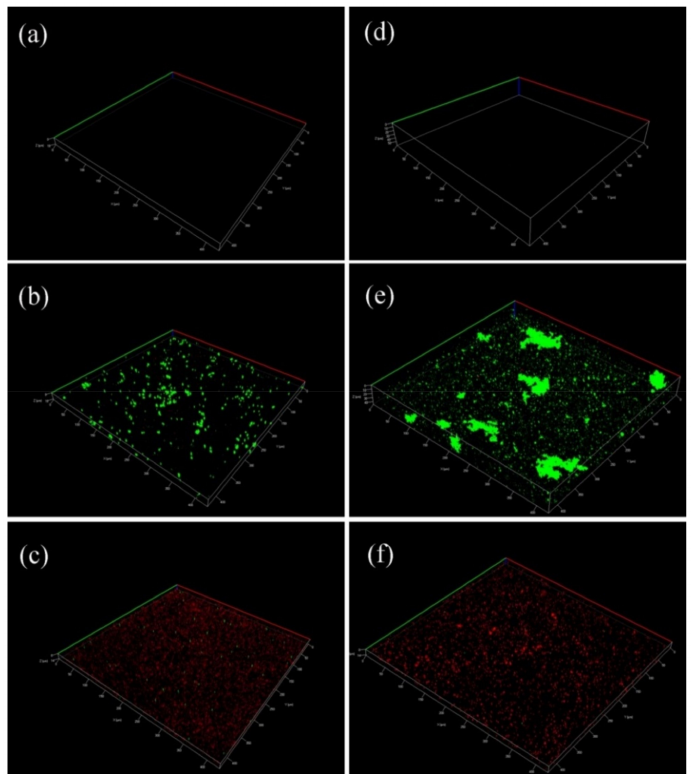
Figure 4. CLSM 3D images of the 304SS coupons after different immersion times in various solutions: ( a ) blank for 14 days; ( b ) SRB for 14 days; ( c ) BDMDAC for 14 days; ( d ) blank for 28 days; ( e ) SRB for 28 days; and ( f ) BDMDAC for 28